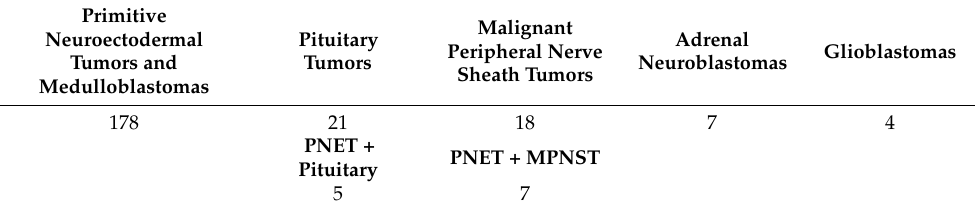
Table 1. Tumor phenotypes developed by JCPyV transgenic mice. Characterization of the tumors was based on the World Health Organization Classification of Brain Tumors. Other phenotypes included 5 lymphomas, 2 angiosarcomas, 1 papillary carcinoma of the thyroid, and 1 endodermal sinus